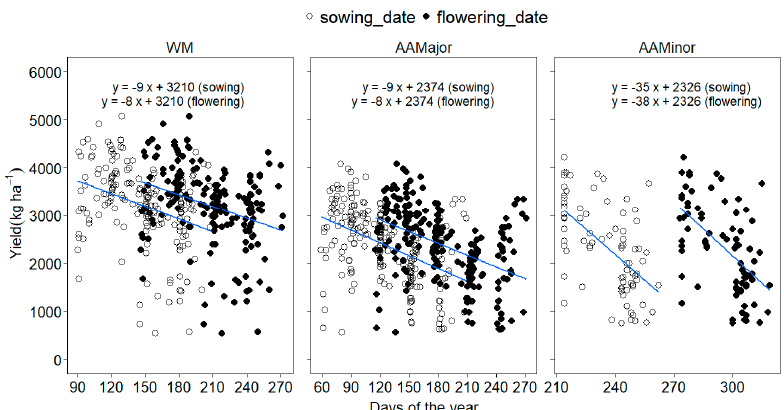
Figure 9. Simulated long term grain yield against sowing and flowering day of the year (April (91–121), May (121–152), June (152–182), July (182–2113), August (210–244), September (244–274), October (274–300)) for 75 kg N ha − 1 and 1.20 m rooting depth. Maize below 500 kg ha − 1 was considered as crop failure. Intercepts of the regression equations are centered around mean yield. The slope indicates the amount of yield (y) (kg ha − 1 ) that declines for each day a sowing or flowering (x) delays. Agriculture 2020 , 10 , x FOR PEER REVIEW